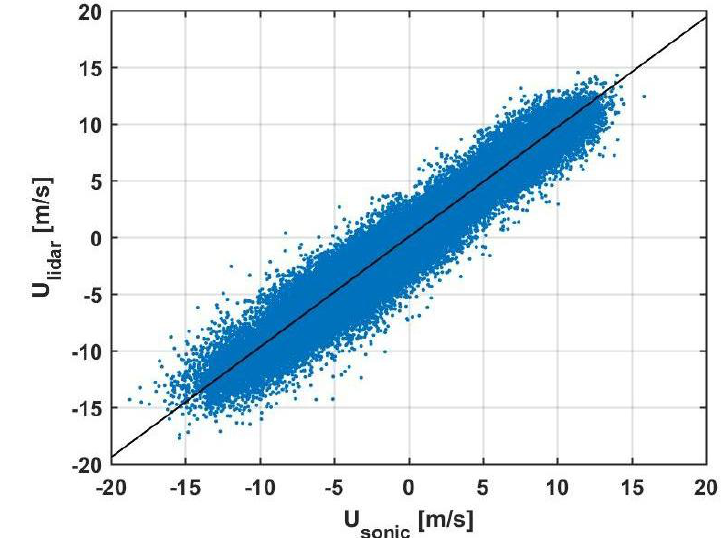
Figure 10. Correlation plot of one-second velocities from 13 April 2015–11 June 2015. The coefficient of determination is R 2 = 0.9454 and the linear regression slope is 0.9705.